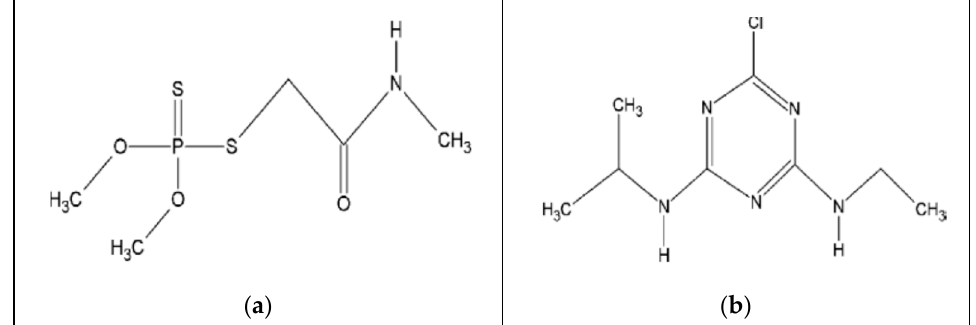
Figure 5. Structures of pesticides; ( a ) dimethoate and ( b ) atrazine.